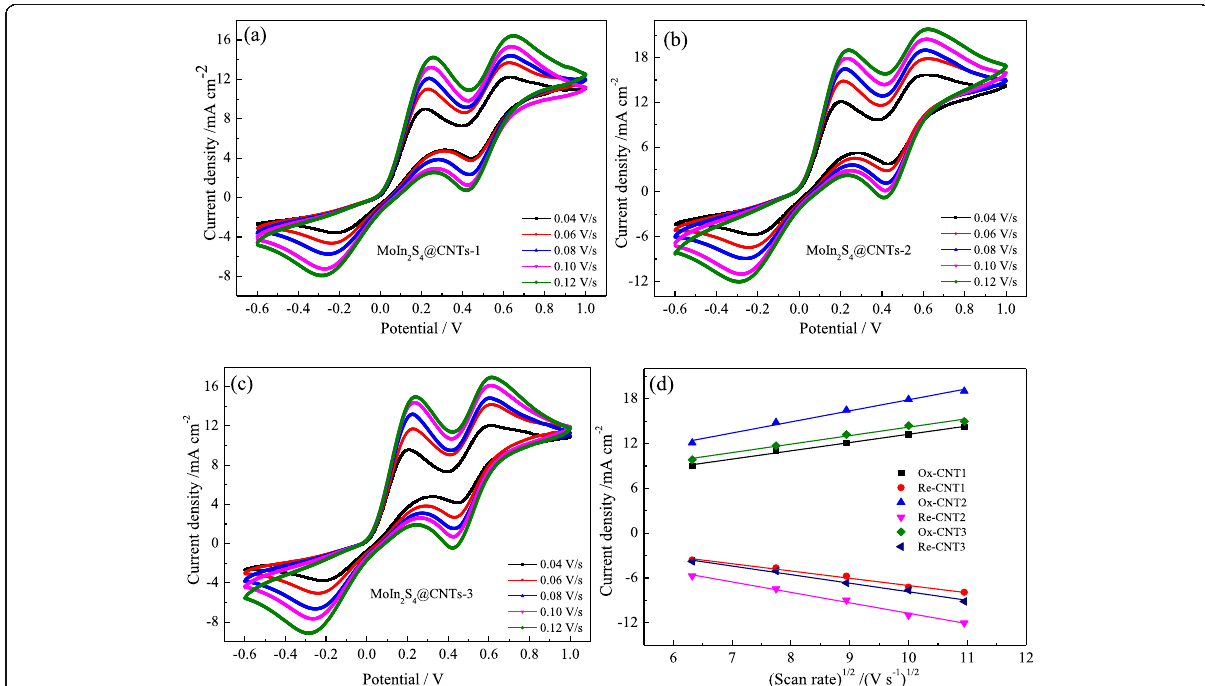
Fig. 6 CVs of the MoIn 2 S 4 @CNTs CEs at different scan rates a MoIn 2 S 4 @CNTs-1, b MoIn 2 S 4@ CNTs-2, c MoIn 2 S 4 @CNTs-3, and d the influences of the scan rate on the redox peaks current